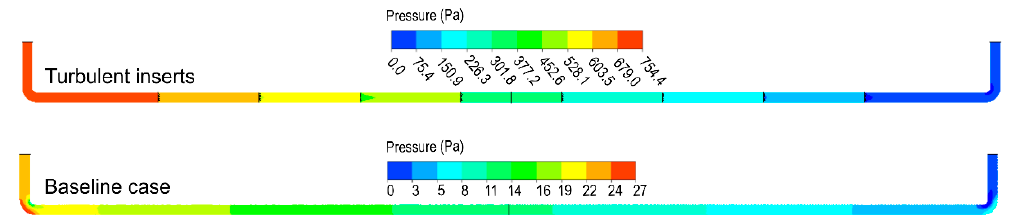
Figure 8. Pressure drop profile in the middle plane along the pipe for two scenarios.